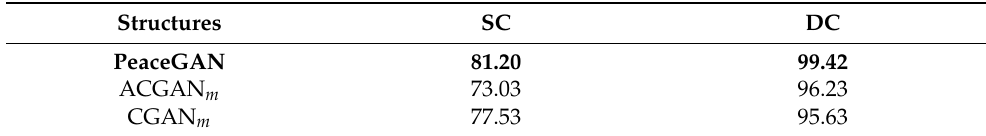
Table 5. The comparison between D Peace (%) by SC and DC.